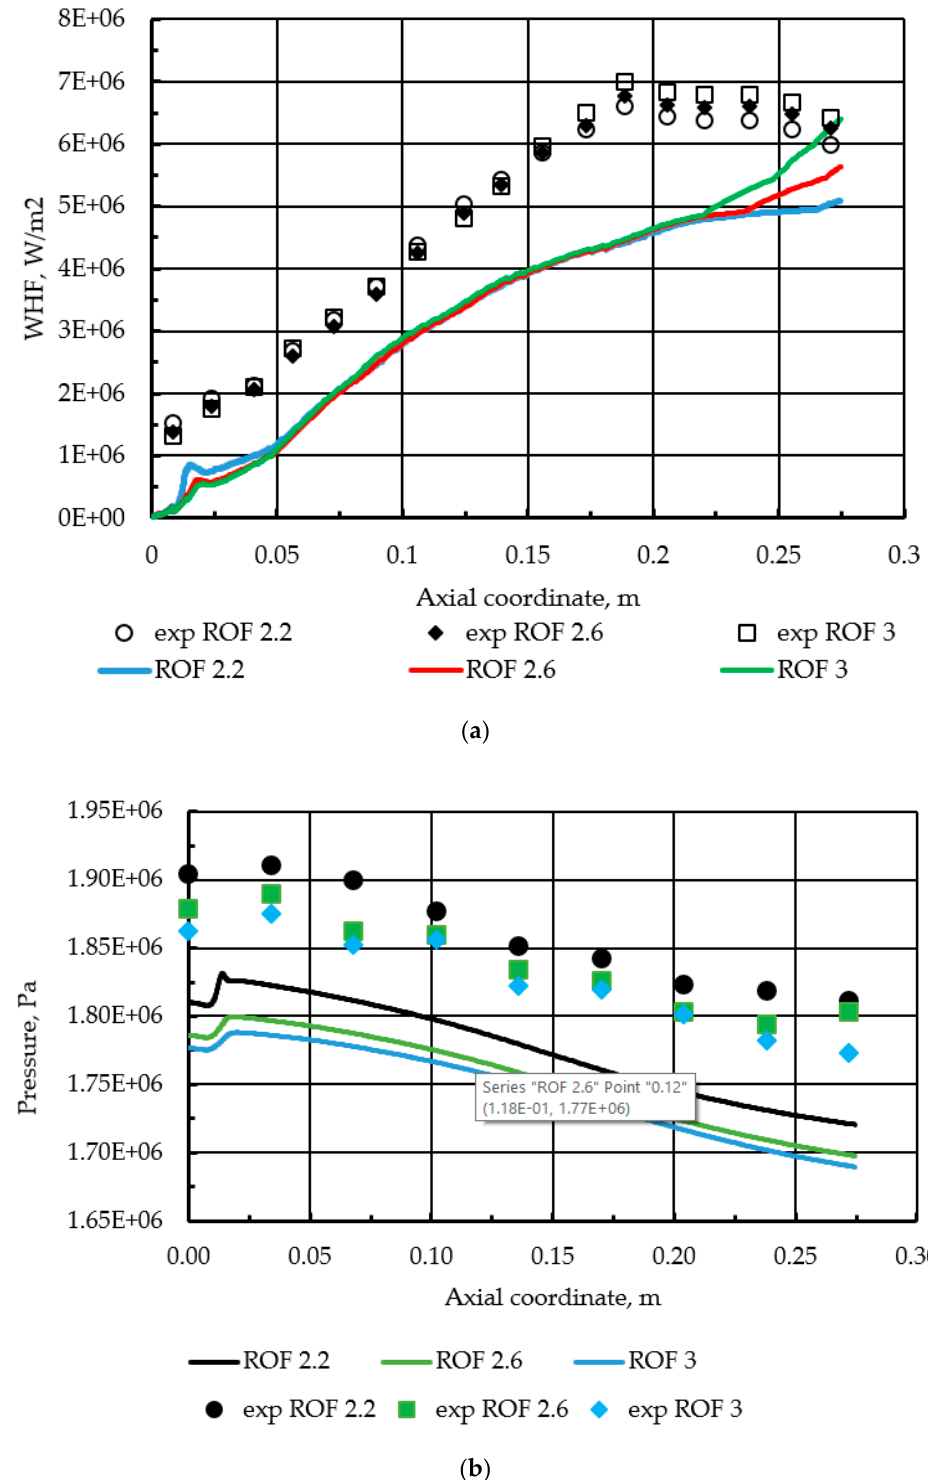
Figure 8. ( a ) Wall heat flux: experiment and simulations at different ROF (def = 2.2); ( b ) Pressure: experiment and simulations at different ROF (def = 2.2).